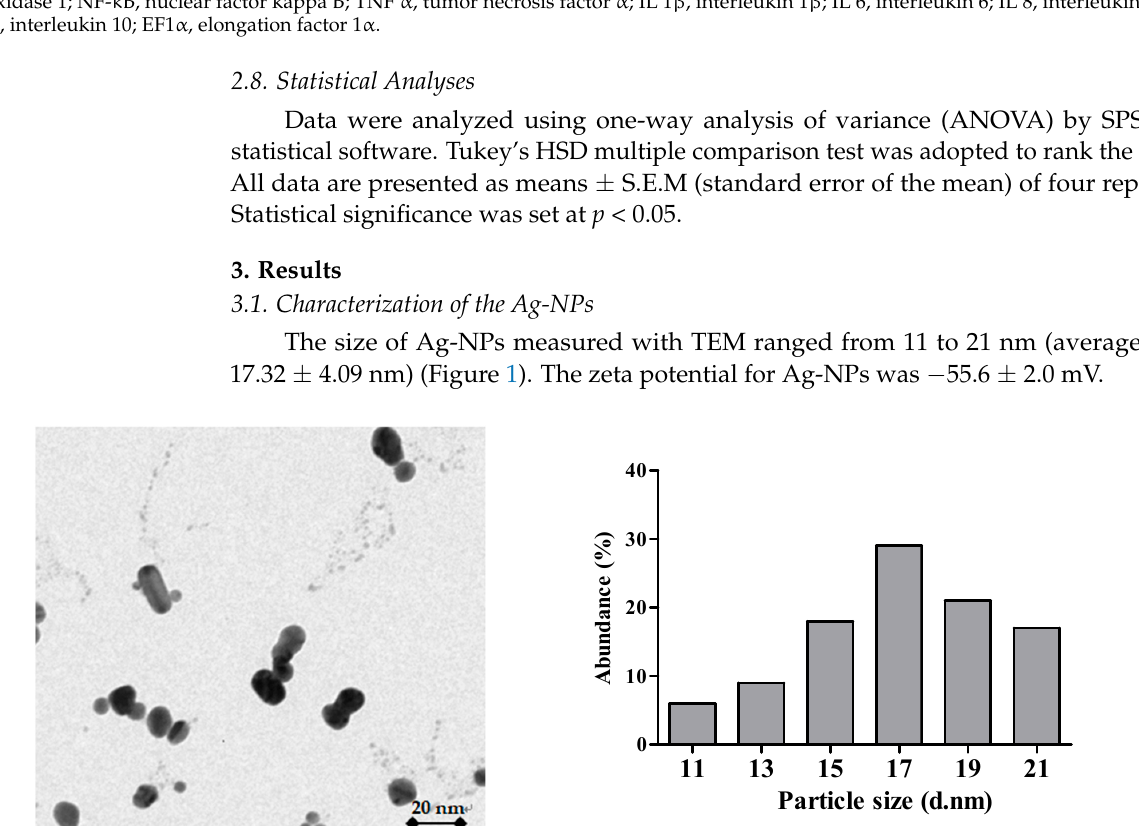
Table 3. Growth performance and feed utilization of blunt snout bream subjected to different treatments. Parameters